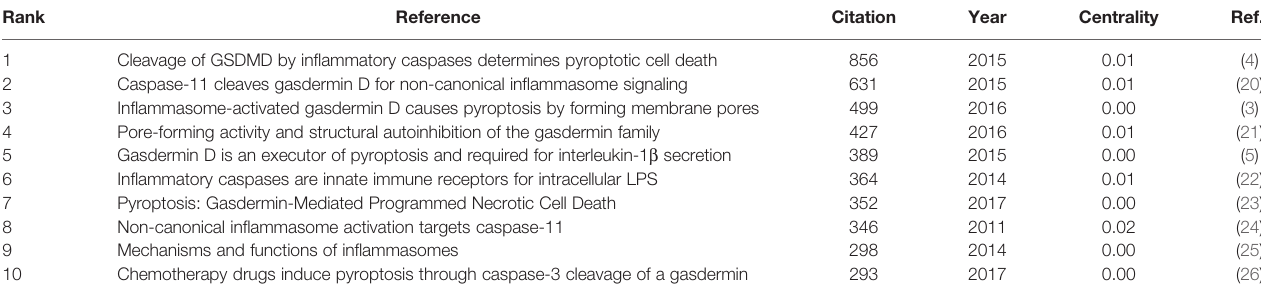
TABLE 4 | Top 10 co-cited references related to